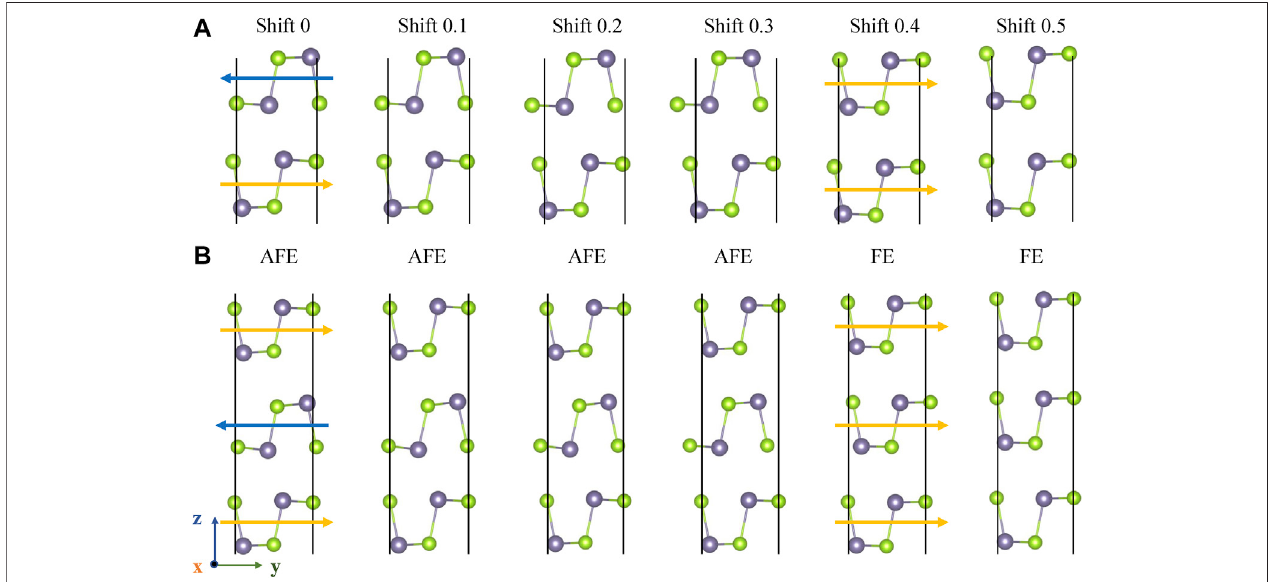
FIGURE4| The evolution structures ofAFE/FEtransition bylayershiftfor (A) bilayerGeSeand (B) trilayerGeSe. Thearrows representtheferroelectric polarization direction.Theshiftn( n (cid:1) 0,0.1,0.2,0.3,0.4,0.5)representthemultiplesoflatticeparameter.Thedirectionofarrowsmeansthepolarizationdirectionofone-layerGeSe.